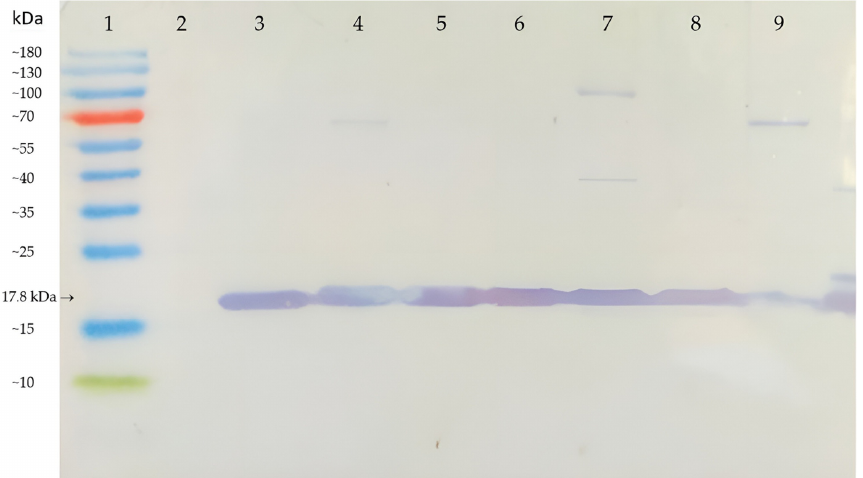
Figure 5. Reactivity of AB-1 antibody with ToMV isolates, TMV, and PMMoV using Western im- munoblotting analysis. Lanes: 1—protein ladder, 2—negative control, 3—ToMV PV-0141, 4—ToMV PV-0143, 5—ToMV PV-0846, 6—ToMV PV-1180, 7—ToMV PV-0135, 8—ToMV SL-1, 9—PMMoV PV-0166, and 10—TMV PV-0107.